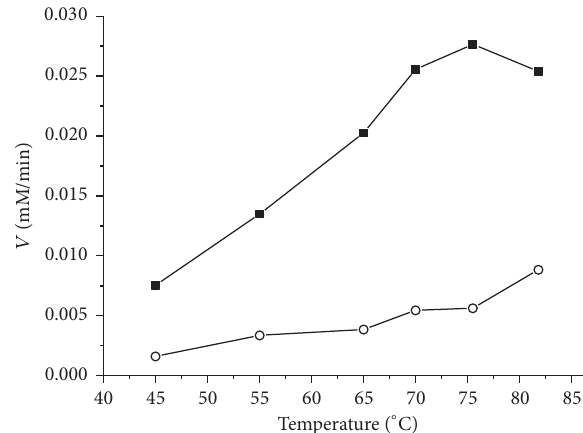
Figure1:Temperaturedependenceoftheinitialrateoftheoxidation of isobutyraldehyde with AlDHPyr1147 corrected for the sponta- neous nonenzymatic reaction ( ◼ ). The reaction was initiated by the addition of 10 𝜇 g of the enzyme to the reaction mixture in standard assay. (o) The initial rate of the spontaneous nonenzymatic reaction.